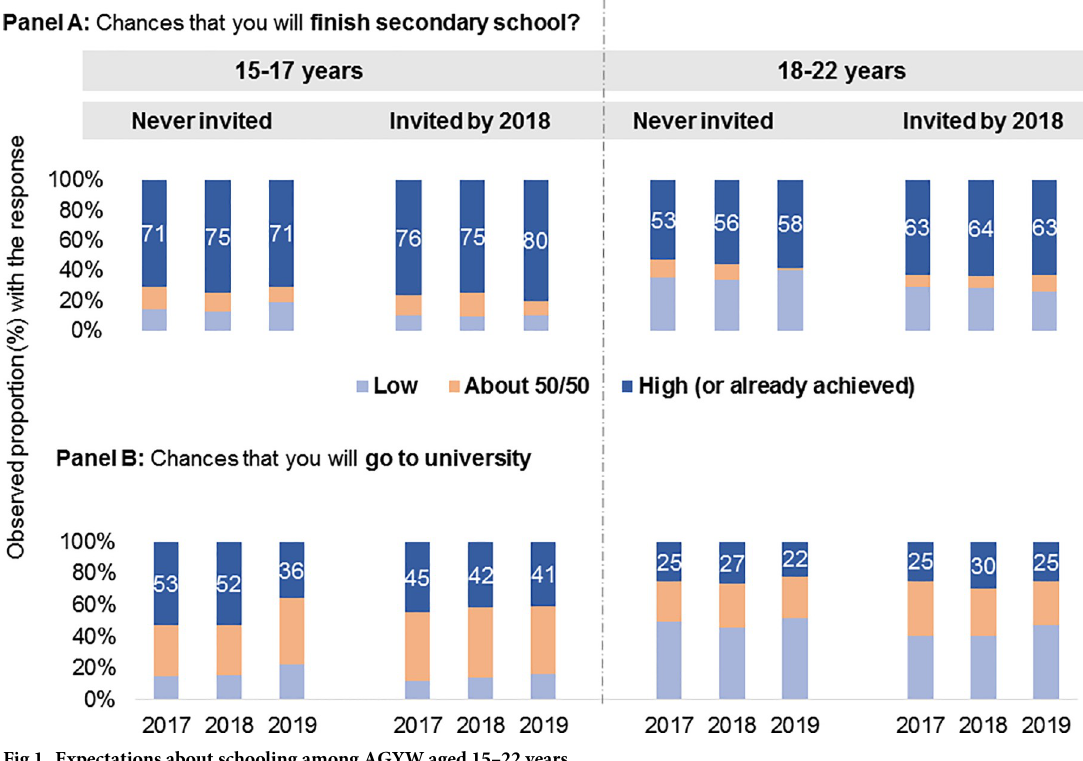
Fig 1. Expectations about schooling among AGYW aged 15–22